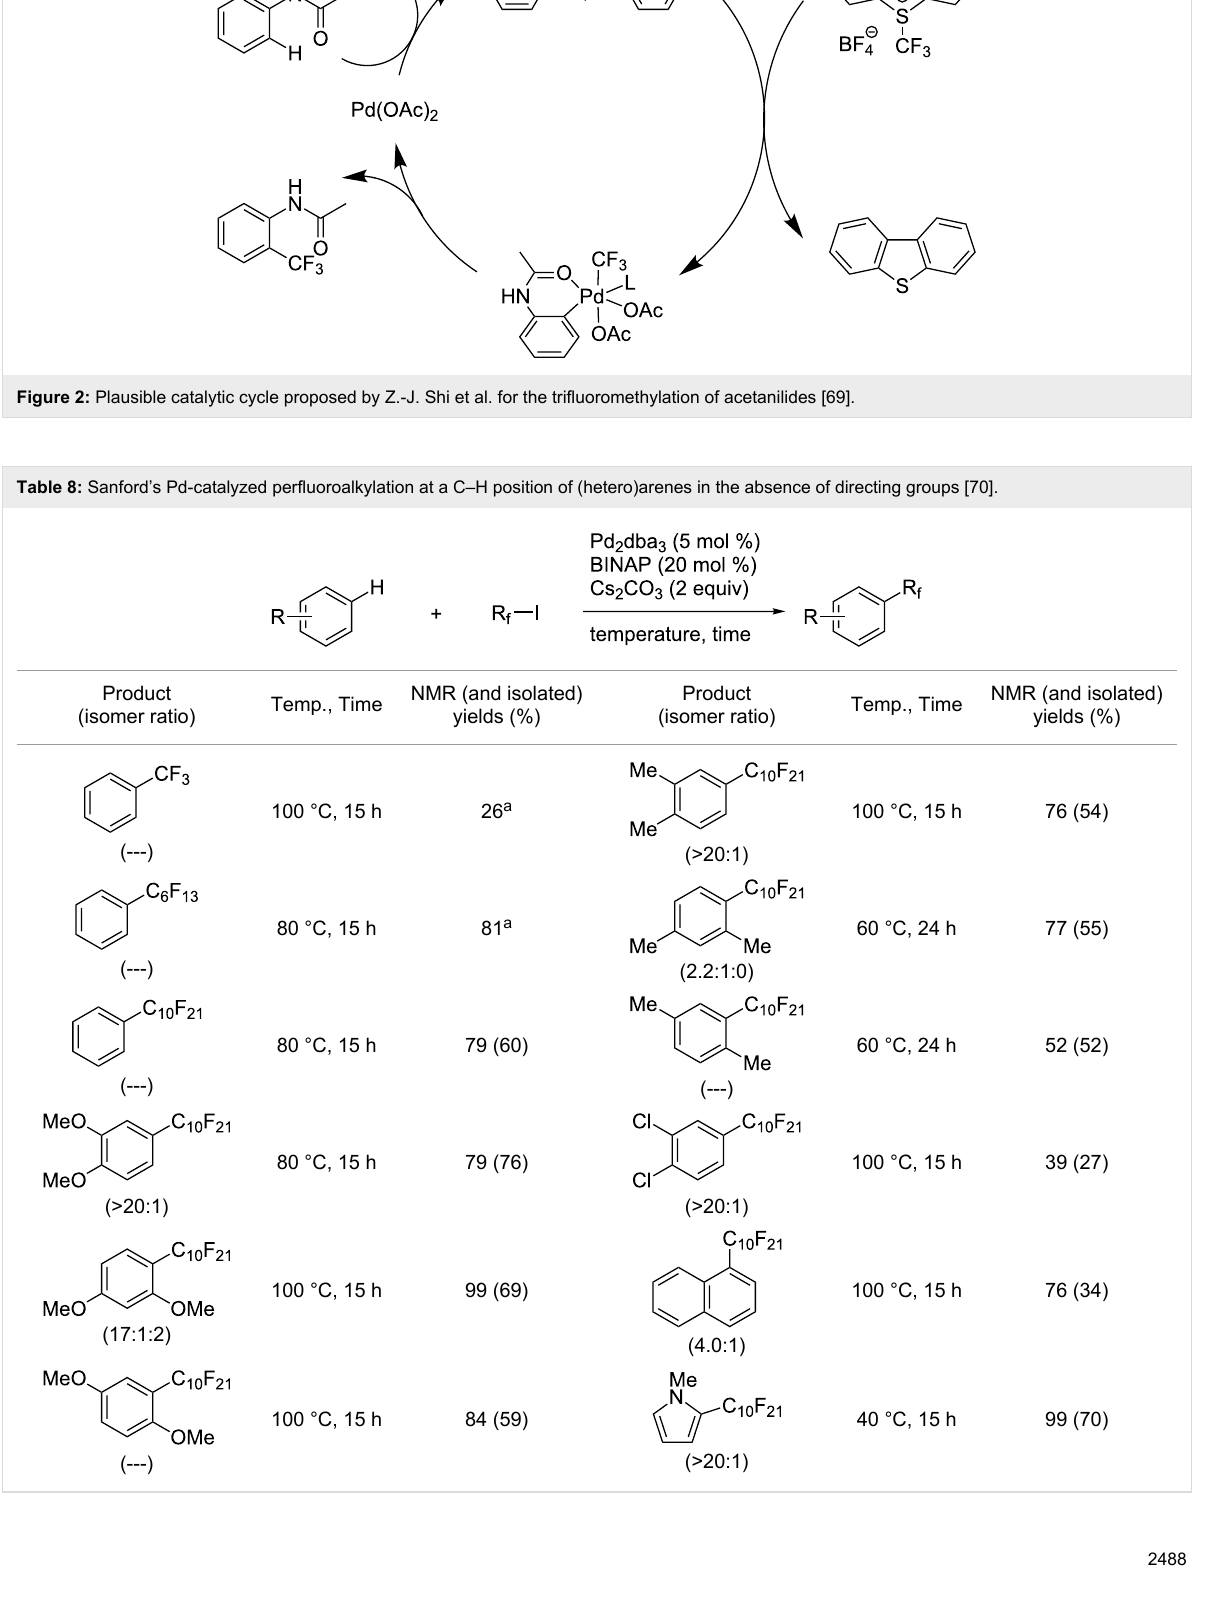
Figure 2: Plausible catalytic cycle proposed by Z.-J. Shi et al. for the trifluoromethylation of acetanilides [69].